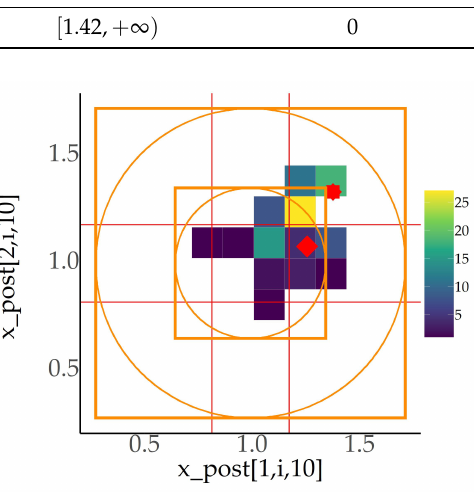
Figure 4. Joint histogram of the particle sample ( i = 1, . . . , N ) for the posterior estimation of both components of the whole hidden vector x 10 . Red lines delimit the suggested grid cells of Table 3. The red diamond stands for the hidden state. The red star stands for the observation at this time point. The sides of the two squares are correspondingly one and two standard deviations σ z from the center of the diagram. The circles are inscribed in the corresponding